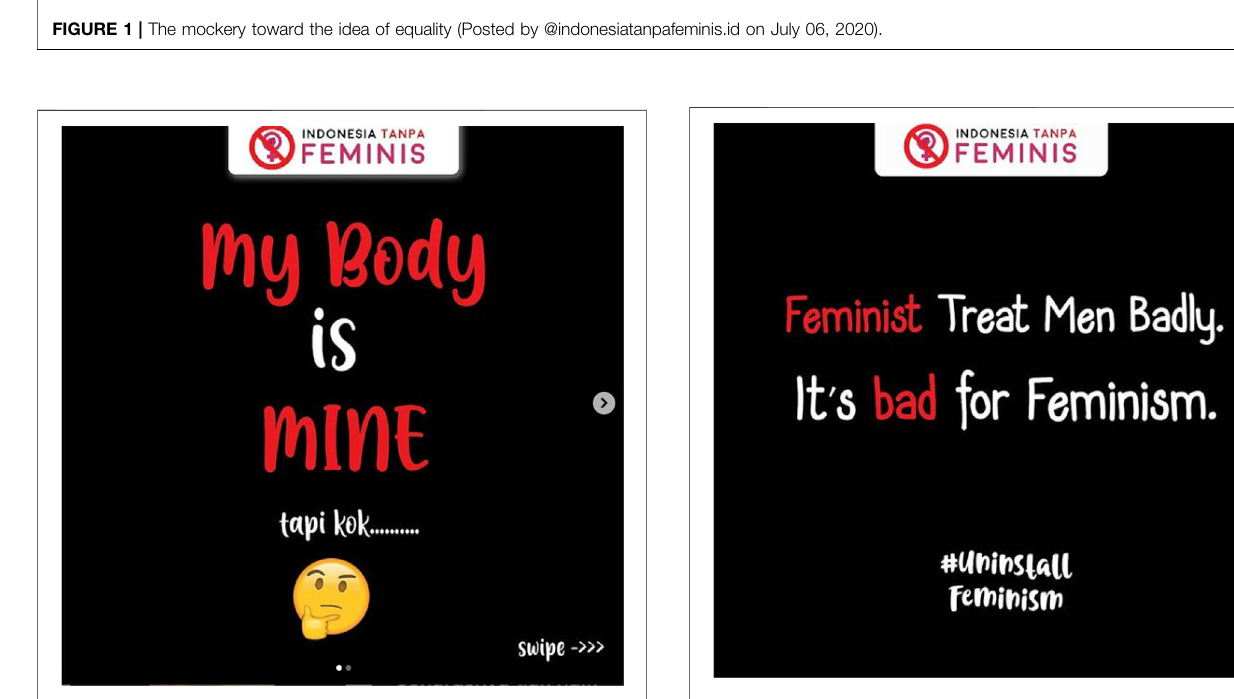
FIGURE 2 | The ownership of women ’ s bodies issue and inconsistency of feminism (Posted by @indonesiatanpafeminis.id on June 17, 2020).